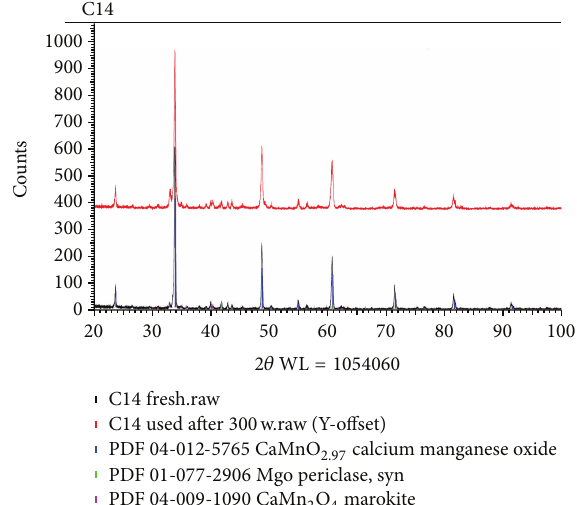
Figure 10: X-ray diffraction pattern including fresh and used CaMn 0.9 Mg 0.1 O 3−𝛿 . An increase in the CaMn 2 O 4 peaks (in magenta at 31, 33, 39, and 44) can be seen in the used particles.